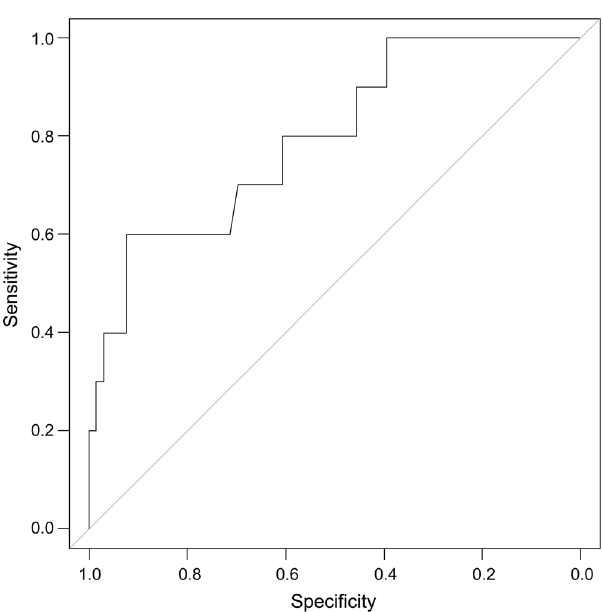
Figure 4. Receiver operating characteristic curve analysis of C-reactive protein level on postoperative day 5.